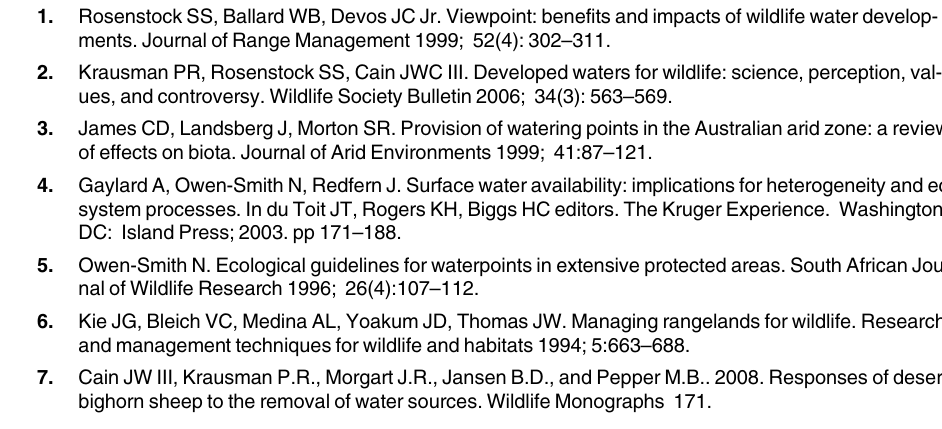
S1 Table. Trail Camera Summary. The elevation, start date, end date and duration (days) of trail cameras operating at water sources in Sevilleta National Wildlife Refuge, New Mexico, USA. S2 Table. Correlation. Pearson ’ s Correlation between variables describing weather and time for predicting visitation to water for 9 mammals at Sevilleta NWR, New Mexico, USA (BC = bobcat, CT = cottontail rabbit, JR = jackrabbit, PH = pronghorn, MD = mule deer, CY = coyote). S3 Table. Model Summary. Models within 7.0 Δ AIC of the model receiving most support, for predicting visitation to water for 9 mammals at Sevilleta National Wildife Refuge, New Mexico, USA (MW = model